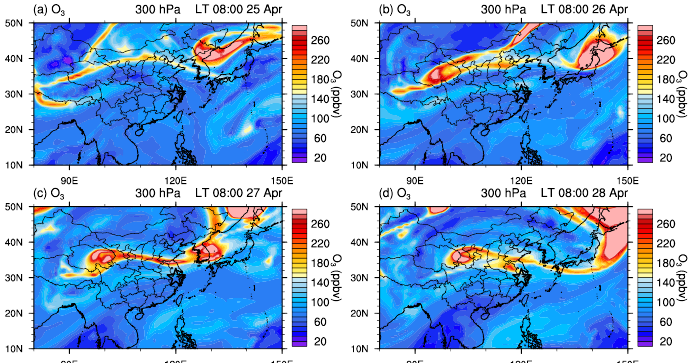
Figure 7. Spatial distribution of ERA5 ozone at 300 hPa over east Asia from 25 April 2018 to 28 April 2018. The black star in each panel indicates the area of interest in this study.